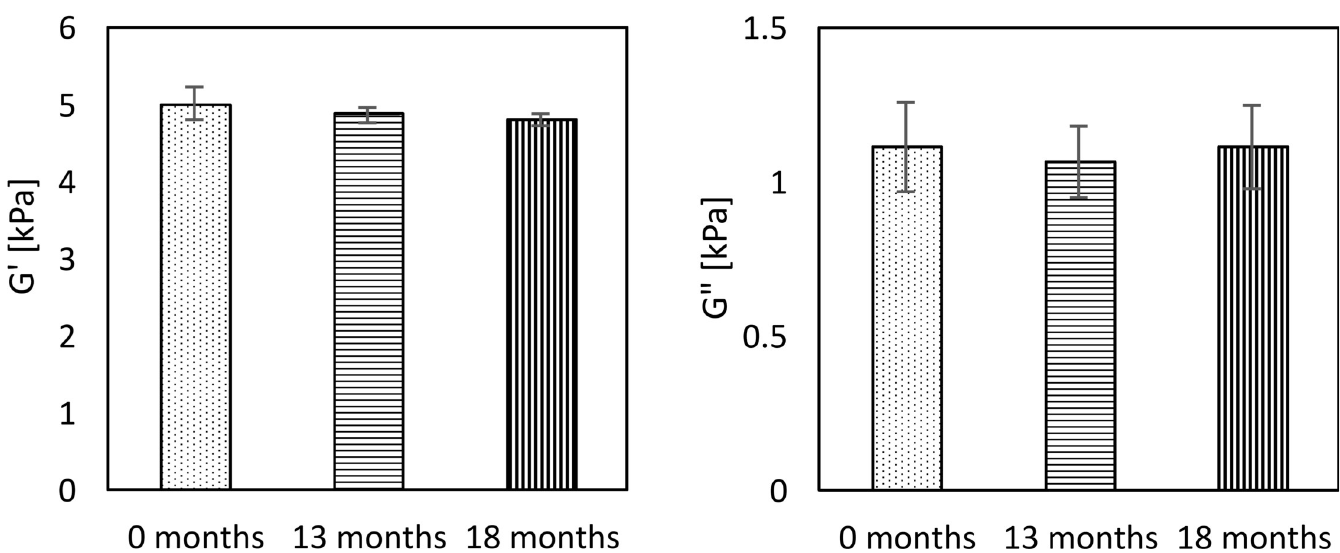
Fig 3. Longitudinal change of the storage modulus (G’) (a) and the loss modulus (G”) (b) obtained from MRE. The error bars represent the SD of five ROIs. There were no statistical differences between G’ and G” over any of the time